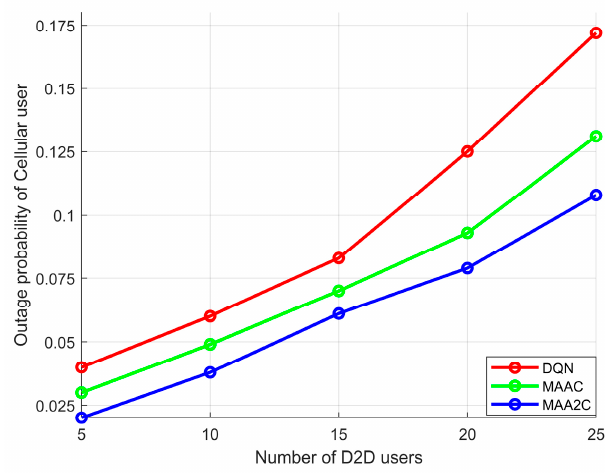
Figure 6. Outage probability of cellular users.